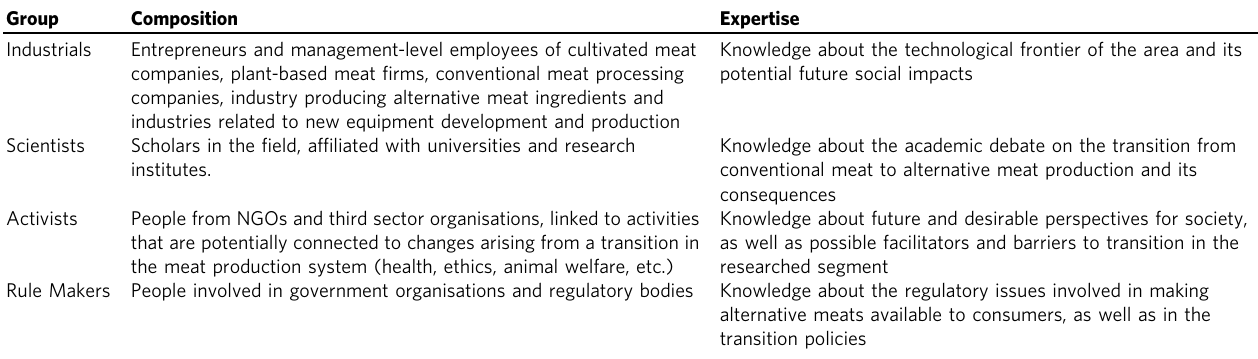
Table 1 Experts sampling and composition per group of